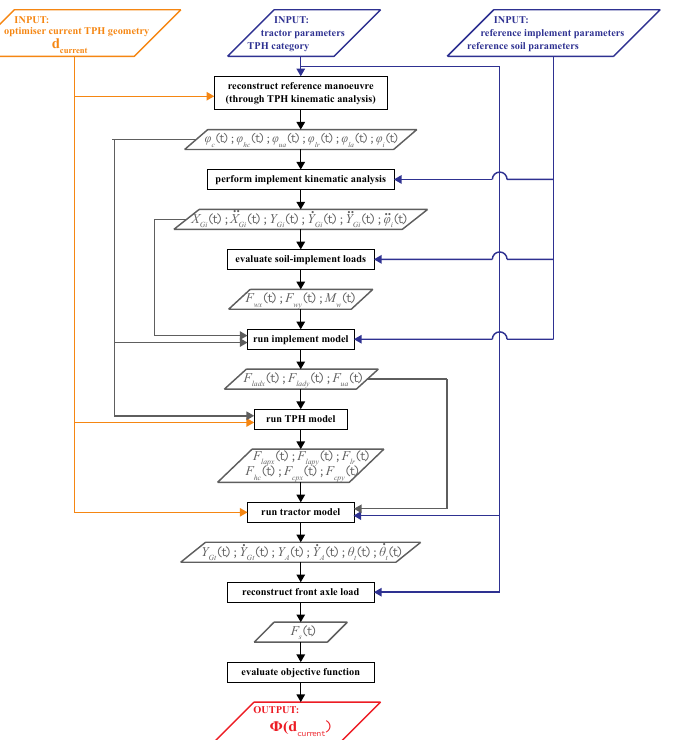
Scheme 2. Algorithm for the evaluation of the objective function to be minimised by the Optimiser. Nomenclature is provided at the end of the